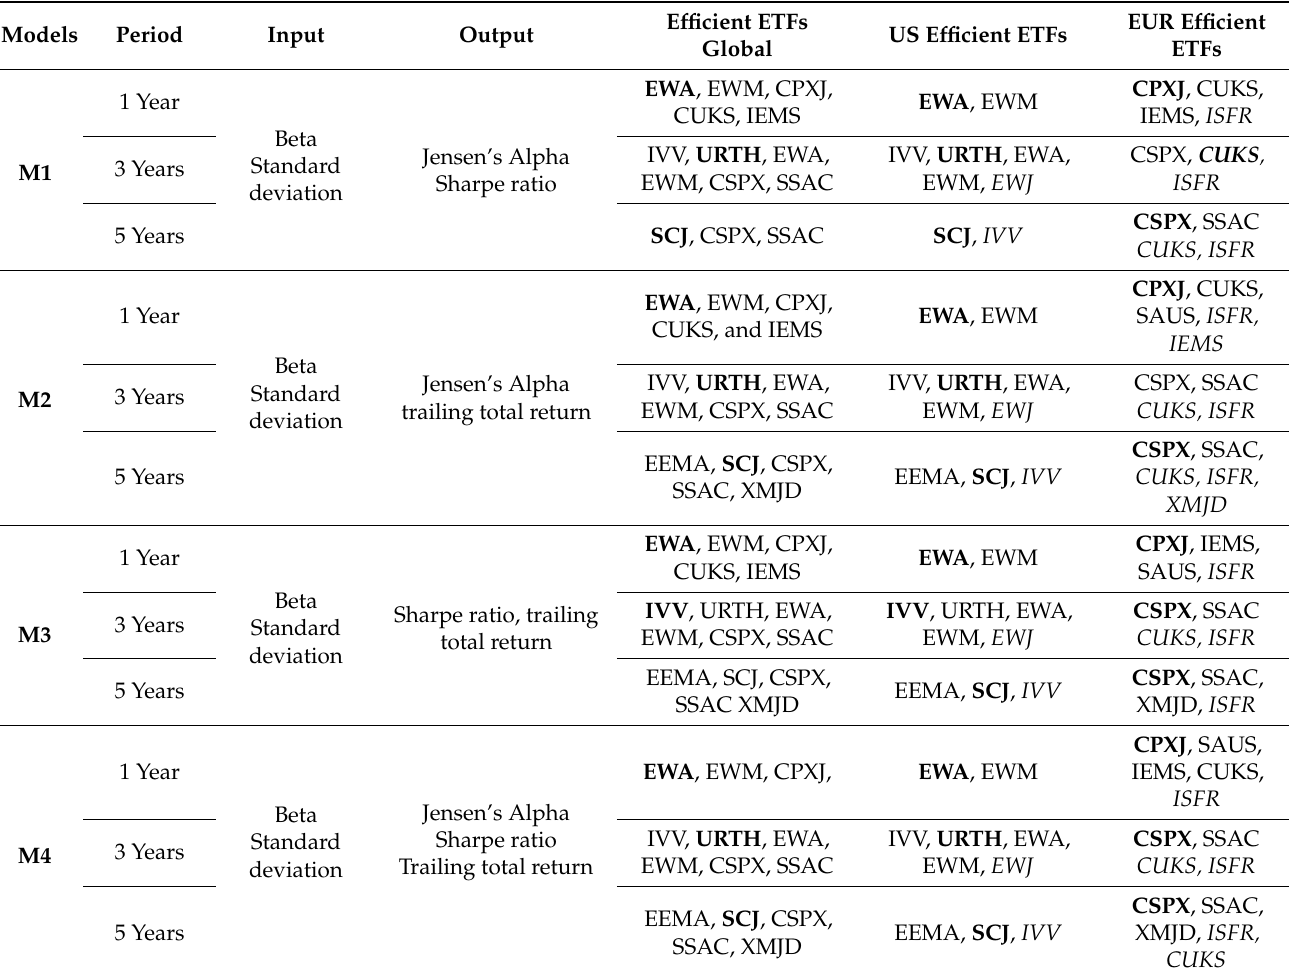
Table 2. Summary table of efficient ETFs from the global sample and by